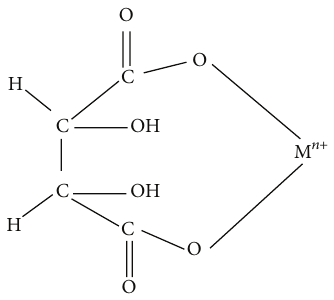
Figure 1: Chelating between complex cations and acid like citric